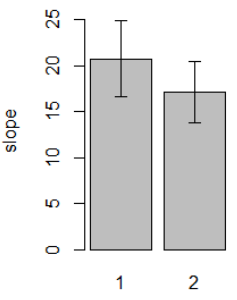
Figure 6. the distribution of slope values in conserved (1) and degraded (2)